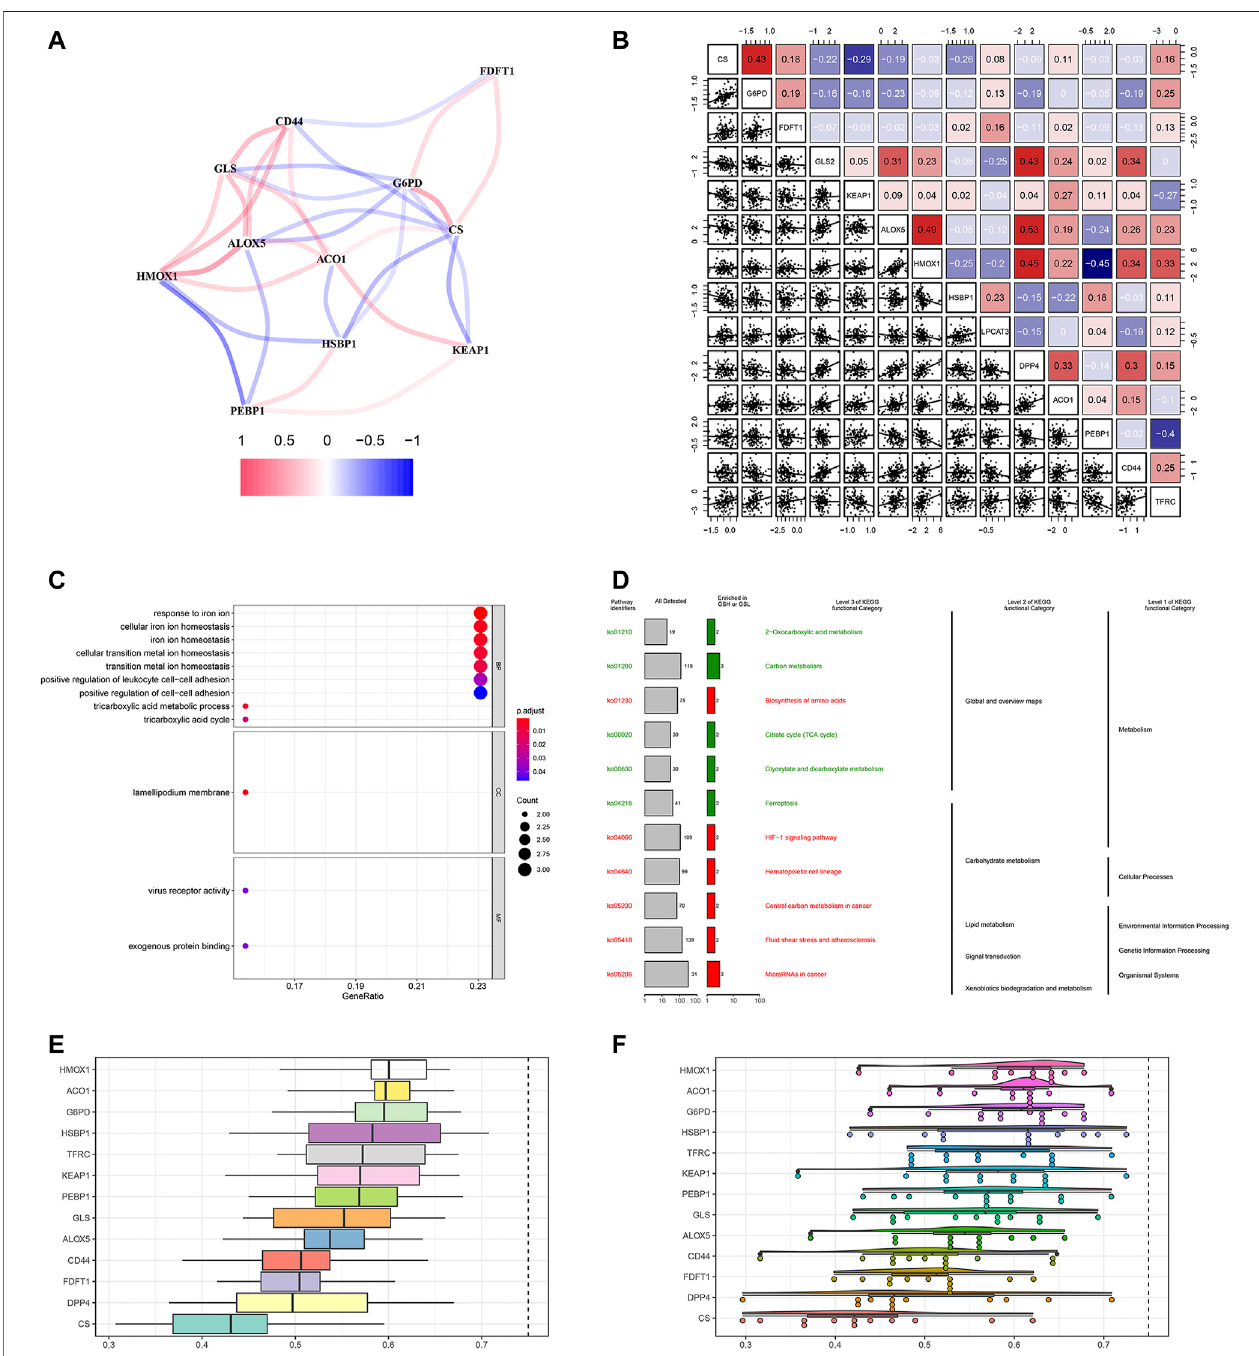
FIGURE2| Genecorrelationnetworkandenrichmentanalysis. (A) ThecorrelationnetworkofFRG. Thecorrelationcoef fi cientsarerepresented bydifferentcolors, in which red lines represent positive correlation, while negative in blue. (B) Gene interaction analysis. The correlations were represented in the data. (C) GO analysis results showed FRG were enriched in the iron homeostasis and ferroptosis-related pathways. (D) KEGG enrichment demonstrated metabolic activities and ferroptosis. (E) SummaryofFRGsimilarities.Theboxesindicatedthemiddle50%ofthesimilarities;andtheupperandlowerboundariesshowthe75thand25thpercentile. (F) Raincloud plots of OGG. Data were shown as the mean and standard error. Each dot represented a single gene. The dashed line represents the cutoff value (0.75).